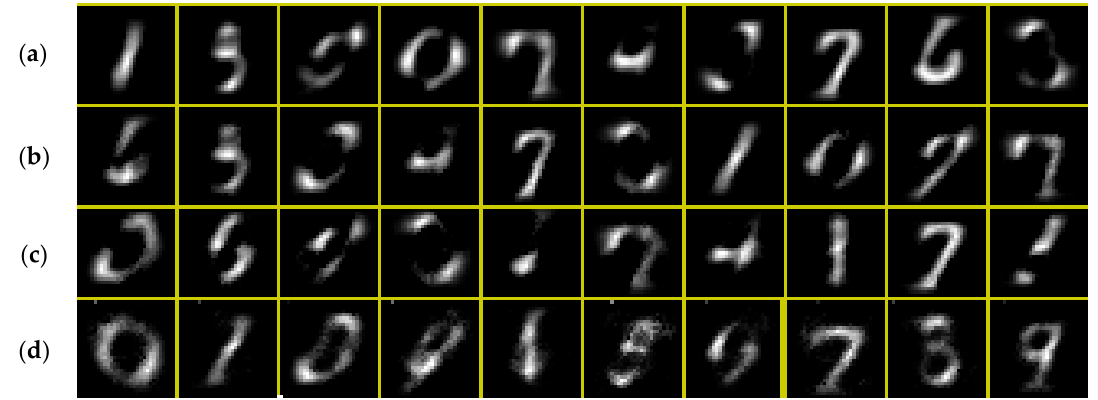
Figure A3. Numbers data ( a ) LDA topics with 10,000 images, ( b ) LDA topics with 1000 images, ( c ) ERT model with 1000 images using LDA boosts, ( d ) ERT with 1000 images improved high-level data.